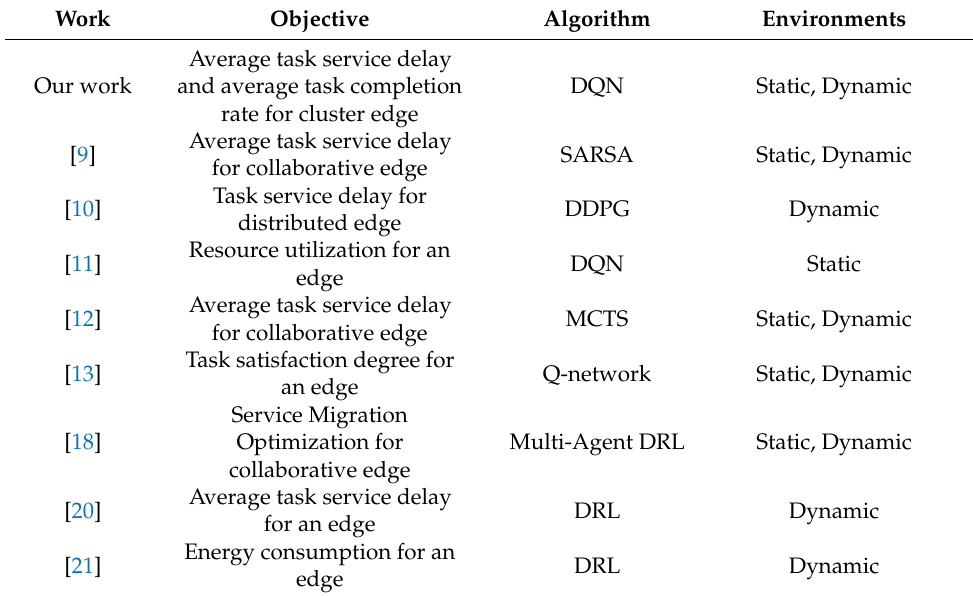
Table 1. Comparison of relevant